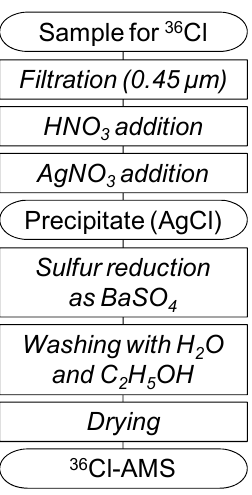
Figure 5. Summary of the sample preparation scheme for 36